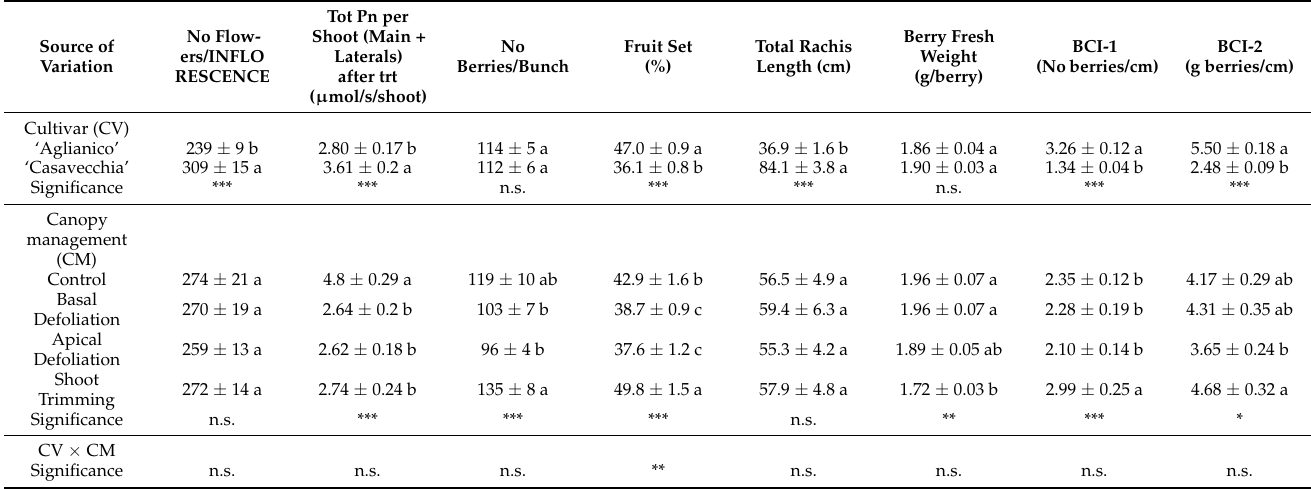
Table 2. Effect of the cultivar (CV: ‘Aglianico’ and ‘Casavecchia’), canopy management (CM: control, basal defoliation, apical defoliation, shoot trimming) and the CV × CM interaction (assessed by two-way ANOVA) on the number of flowers per bunch (at stage H before the application of the CM treatments), estimated total shoot photosynthetic rate measured at stage H right after the application of canopy management treatments. and number of berries per bunch, fruit set total rachis length, berry fresh weight, and the two bunch compactness indices (BCI-1 and BCI-2) measured at harvest. N.s., *, **, and ***: not significant, or significant at p ≤ 0.05, 0.01, and 0.001, respectively. Separately for each source of variation and within each column, means followed by different letters are significantly different according to the Tukey test ( p ≤